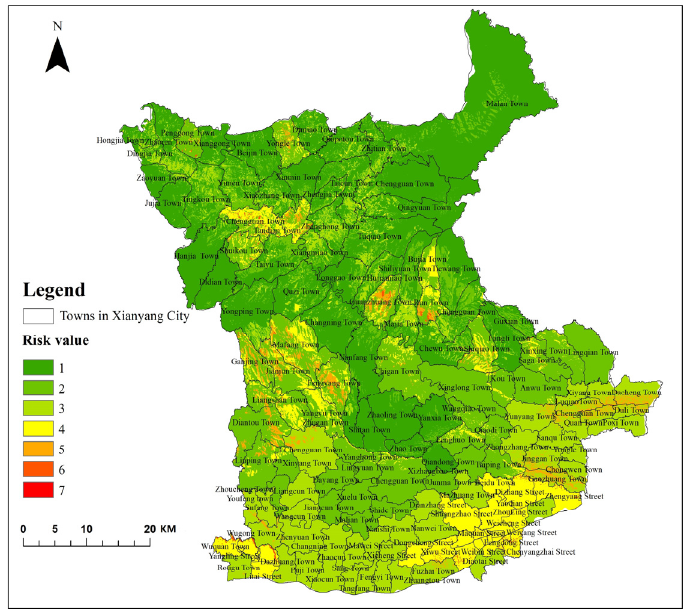
Table 10. Risk zoning standards of the study area.